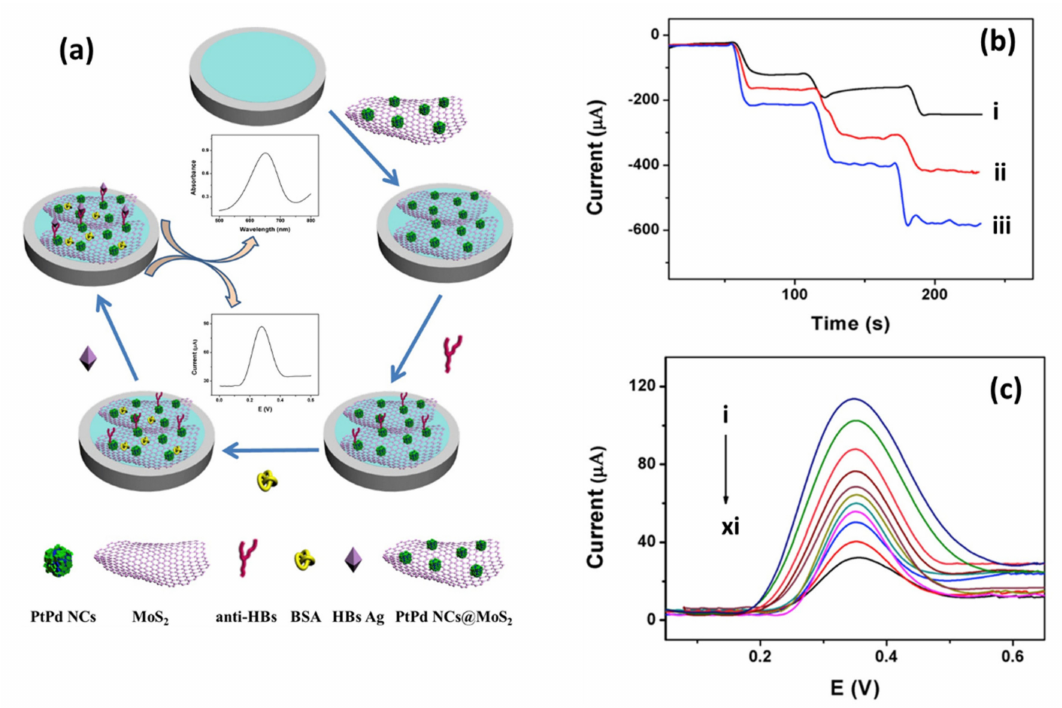
Figure 10. ( a ) Schematic representation of PtPd-MoS 2 for the detection of HBs Ag and signal response mechanism. ( b ) Amperometric response: (curve i) MoS 2 , (curve ii) PtPd NCs, (curve iii) PtPd-MoS 2 in 10 mL PBS (pH = 7.38). ( c ) DPV responses of different concentrations of HBs Ag ranging from (curve i) 32 fg/mL to (curve xi) 100 ng/mL [96]. Figures reproduced with permission from Ref.